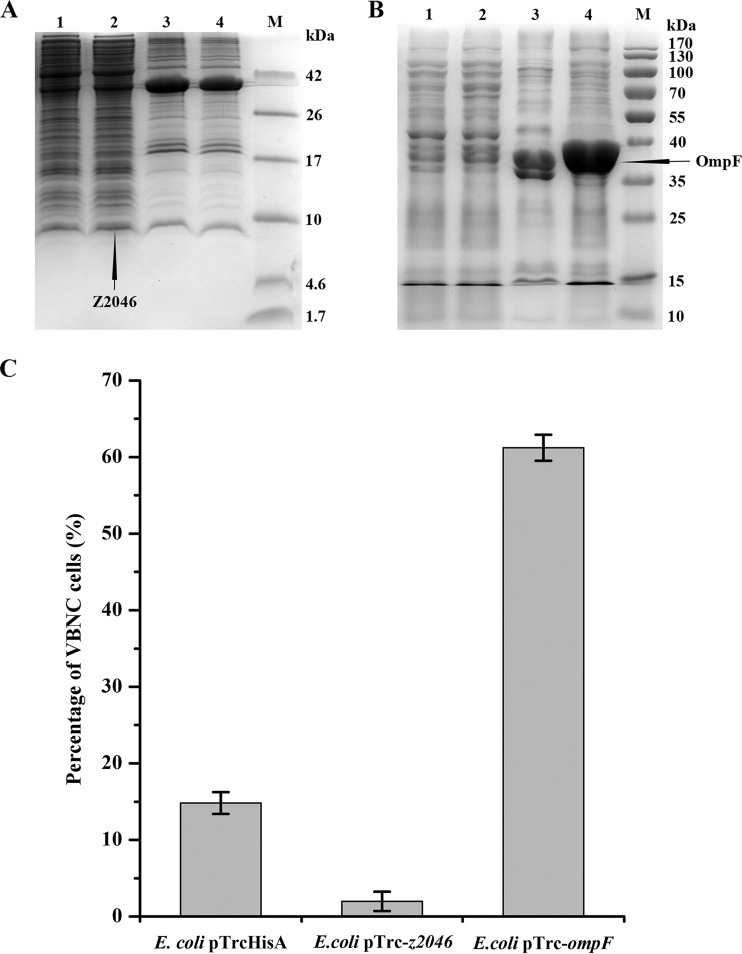
VBNC state formation for recombinant Escherichia coli O157:H7 strains upon HPCD treatment. (A and B) Analysis of homologous expression of z2046 and ompF upon 1 mM IPTG induction using Tricine–SDS-PAGE and SDS-PAGE, respectively. Lanes 1, soluble fraction of E. coli pTrcHisA; lanes 2, soluble fraction of E. coli pTrc-z2046 (A) and E. coli pTrc-ompF (B); lanes 3, insoluble fraction of E. coli pTrcHisA; lanes 4, insoluble fraction of E. coli pTrc-z2046 (A) and E. coli pTrc-ompF (B); lanes M, marker. (C) The percentage of VBNC cells for the control, E. coli pTrc-z2046 and E. coli pTrc-ompF treated by HPCD at 5 MPa and 25°C for 15 min. Error bars represent standard deviation (SD).